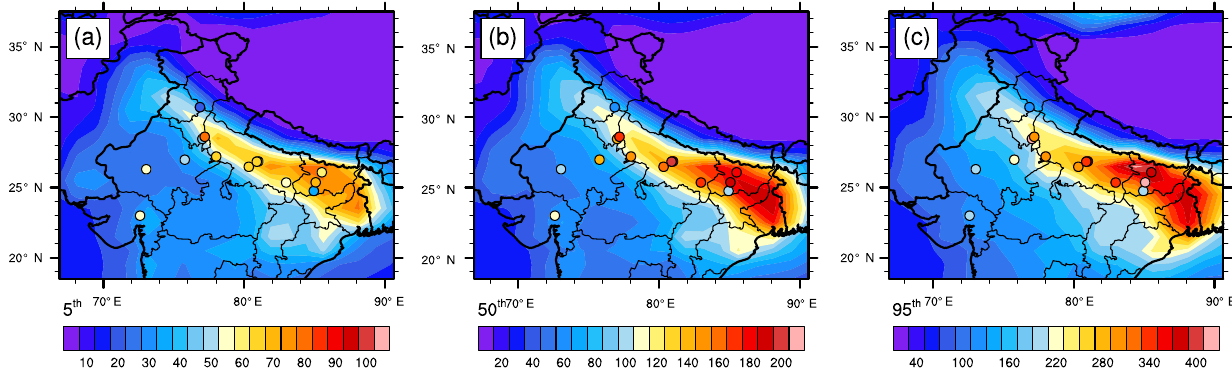
Figure 3. Fractional (%) mass contribution of each component (dust and salt, black carbon (BC), organic matter (OM), ammonium (NH + )) to total PM 2 . 5 for the (a, b) observations collected at Kanpur (26.5 ◦ N, 80.3 ◦ E, 142ma.s.l.) over the sulfate (SO 2 − ), and nitrate (NO − 4 3 period 25 October 2008–30 January 2009 (Ram and Sarin, 2011), where panel (a) excludes the “unidentified” component that is shown in panels (b) , (c) AM4-CMIP5, and (d) AM4-CMIP6.